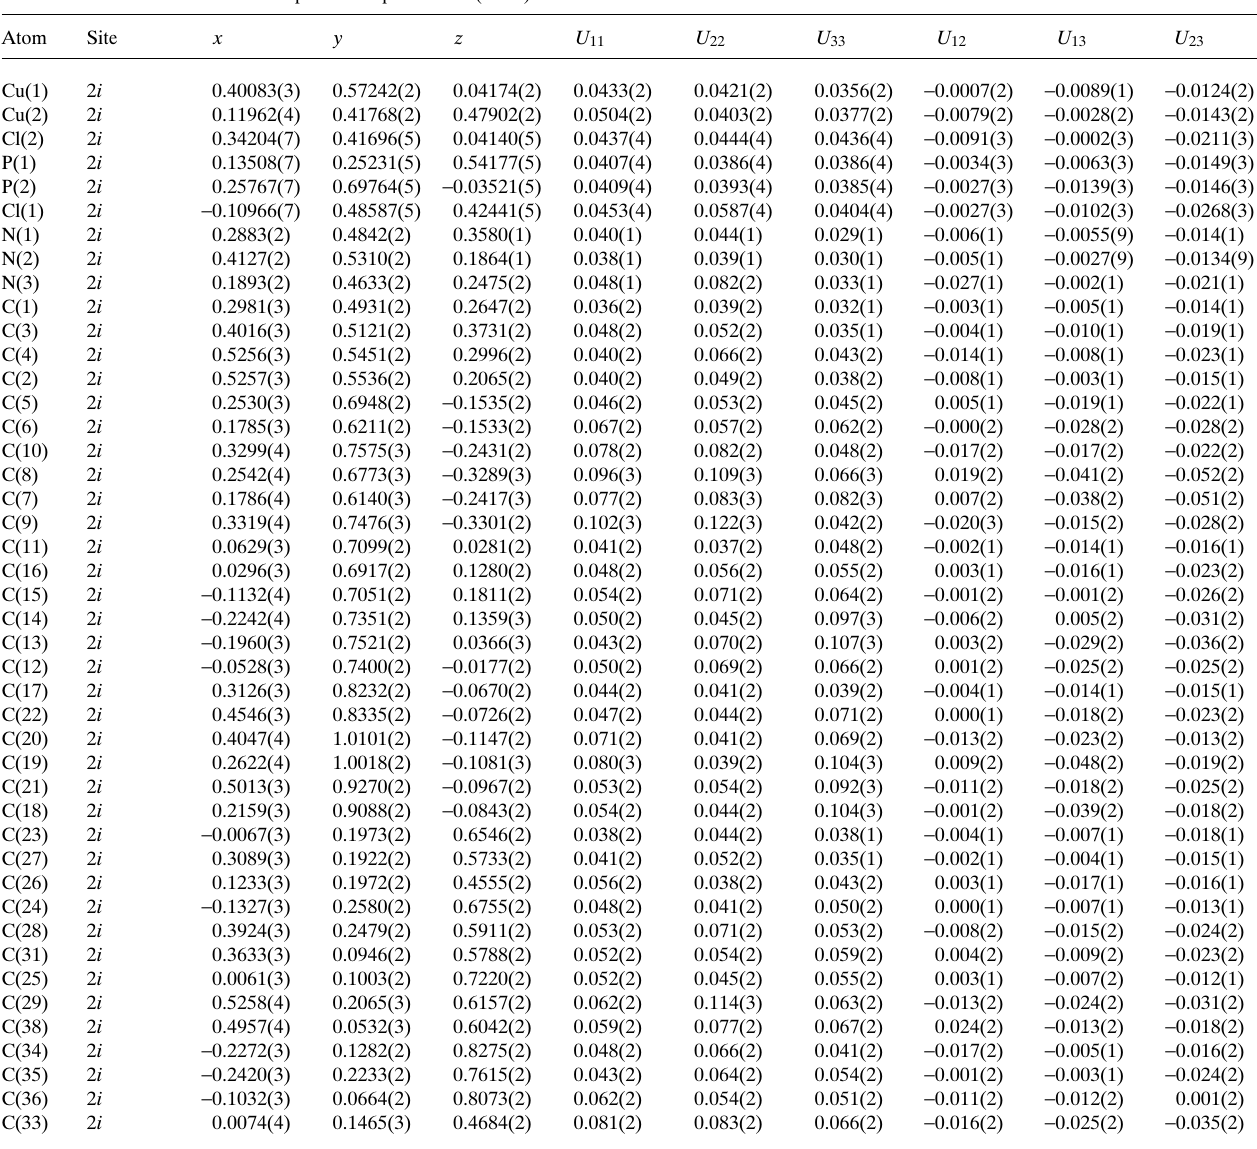
Table 3. Atomic coordinates and displacement parameters (in Å 2 ) .